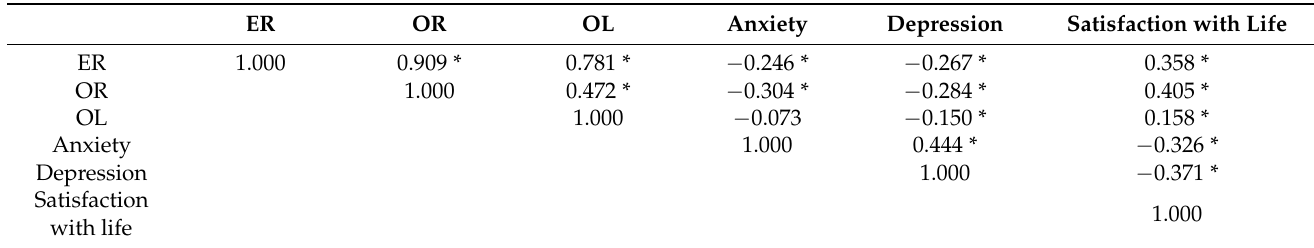
Table 2. Associations between ER, its components, anxiety and depressive symptoms, and satisfaction with life in the entire study group.